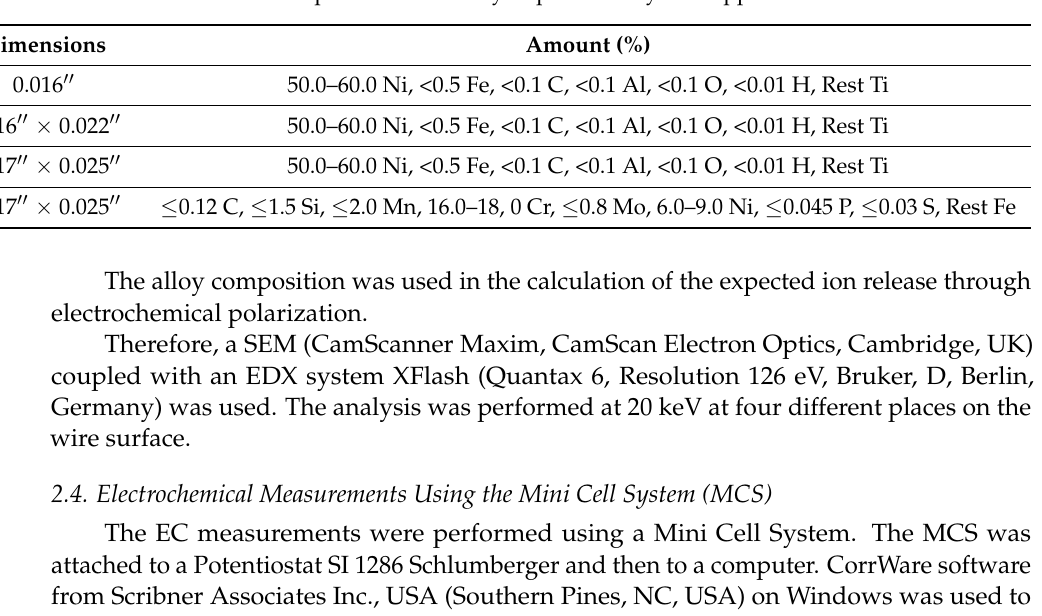
Table 1. The amount of each metal present in the alloy as provided by the supplier.